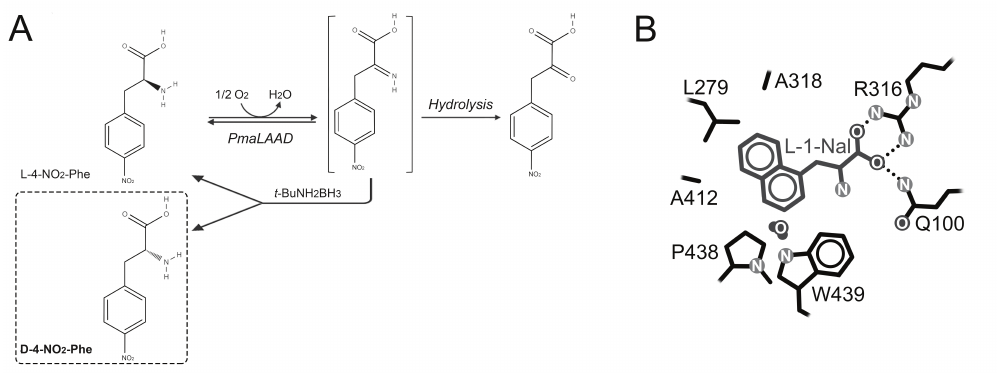
Figure 9. Biocatalytic application of PmaLAAD. ( A ) Stereoinversion of 12.5 mM L-4-NO 2 -phenylalanine, using 62.5 mM borane tert -butylamine, 0.1 mg PmaLAAD / mL, at 25 ◦ C and pH 7.5 [61]; ( B ) schematic structure of the active site of the triple variant F318A / V412A / V438P PmaLAAD with L-1-naphthylalanine modelled as substrate